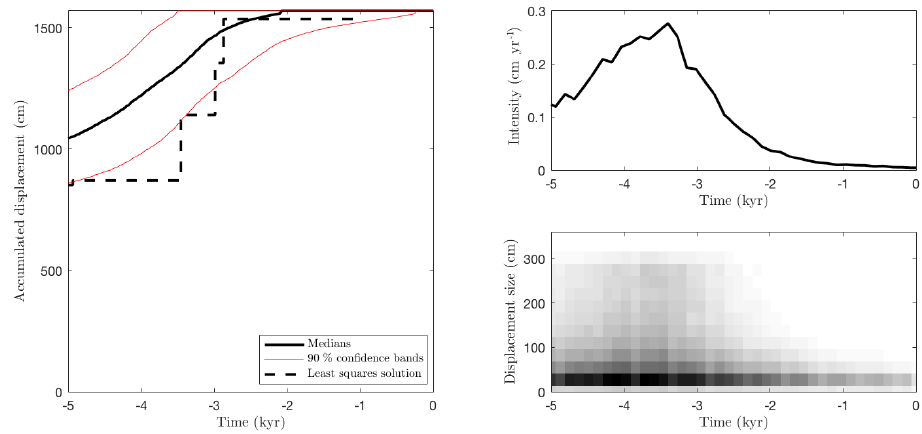
Figure 15. Frattura fault: detailed view of posterior displacement history and earthquake